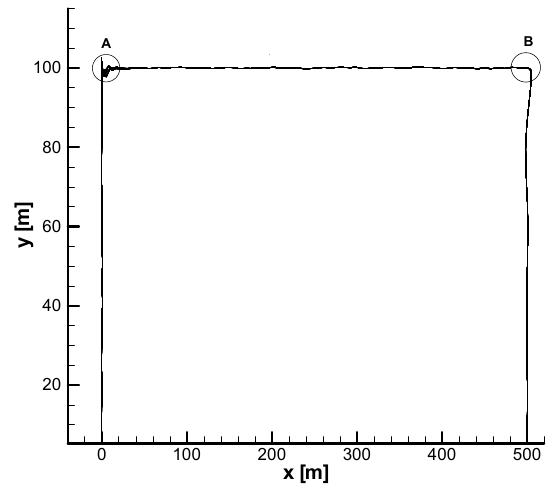
Figure 32. Trajectory beam in lateral view, case 2.